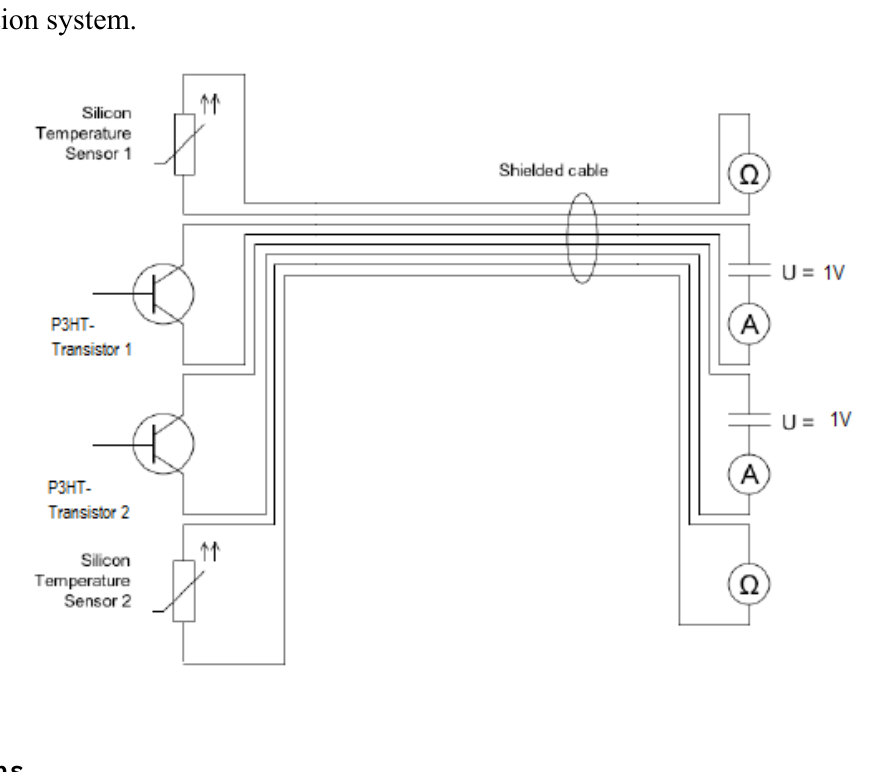
Figure 6. Schematic representation of wire set-up used for temperature sensing using two silicon temperature sensors and two P3HT transistors wired coaxially with the data acquisition